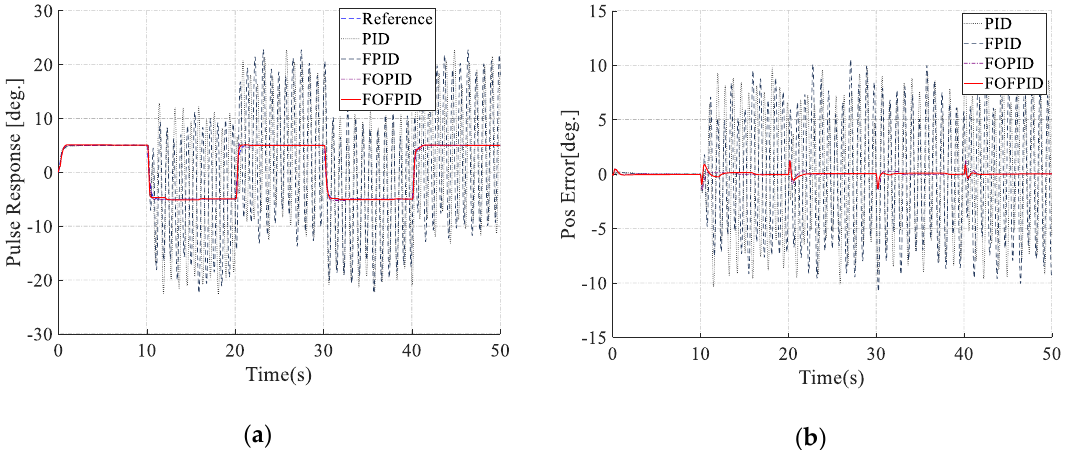
Figure 15. Comparison for pulse trajectory (cutoff frequency 2 Hz and the payload is 50 N). ( a ) Output performance; ( b ) error effort.